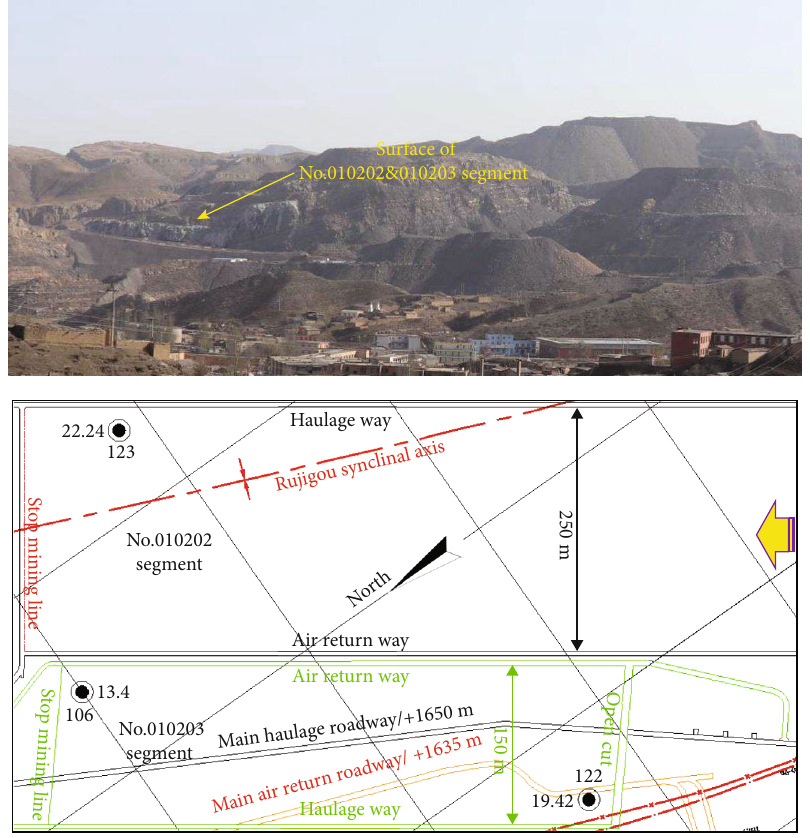
Figure 2: Layout of 010202 and 010203 segment in Rujigou Coal Mine.